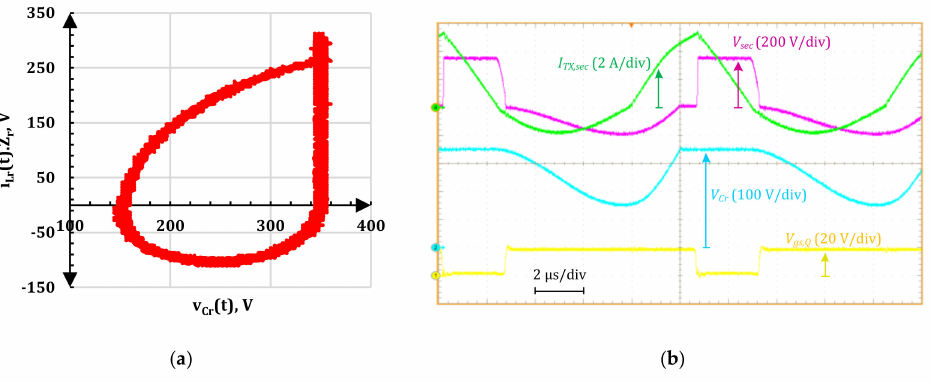
Figure 20. Experimental waveform of the proposed converter for scenario C: ( a ) Trajectory curve, and ( b ) steady-state